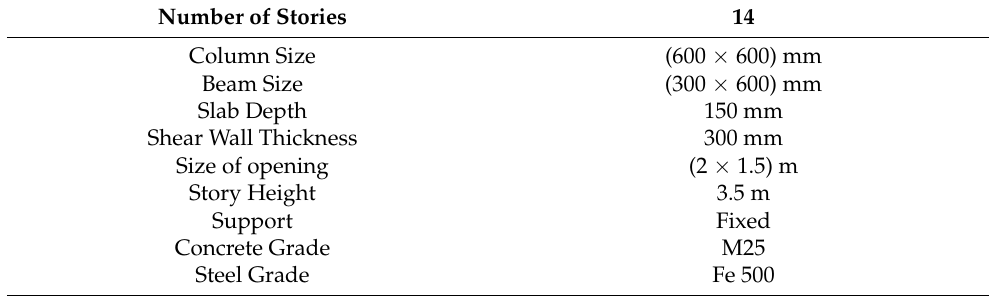
Table 1. Models data.